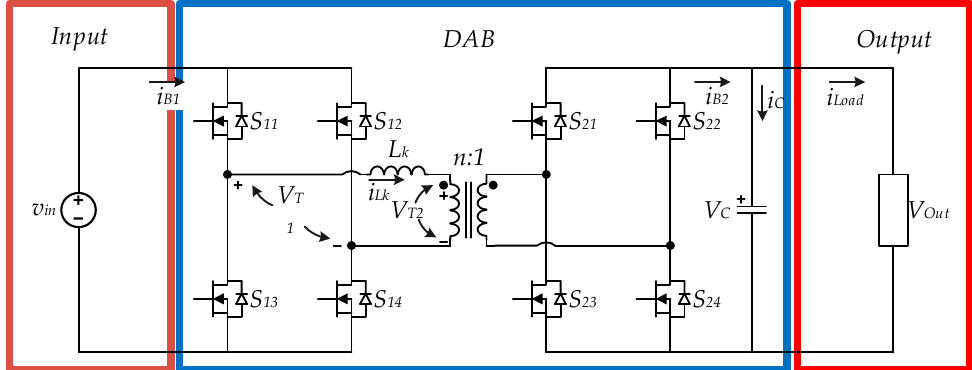
Figure 1. DAB schematic.